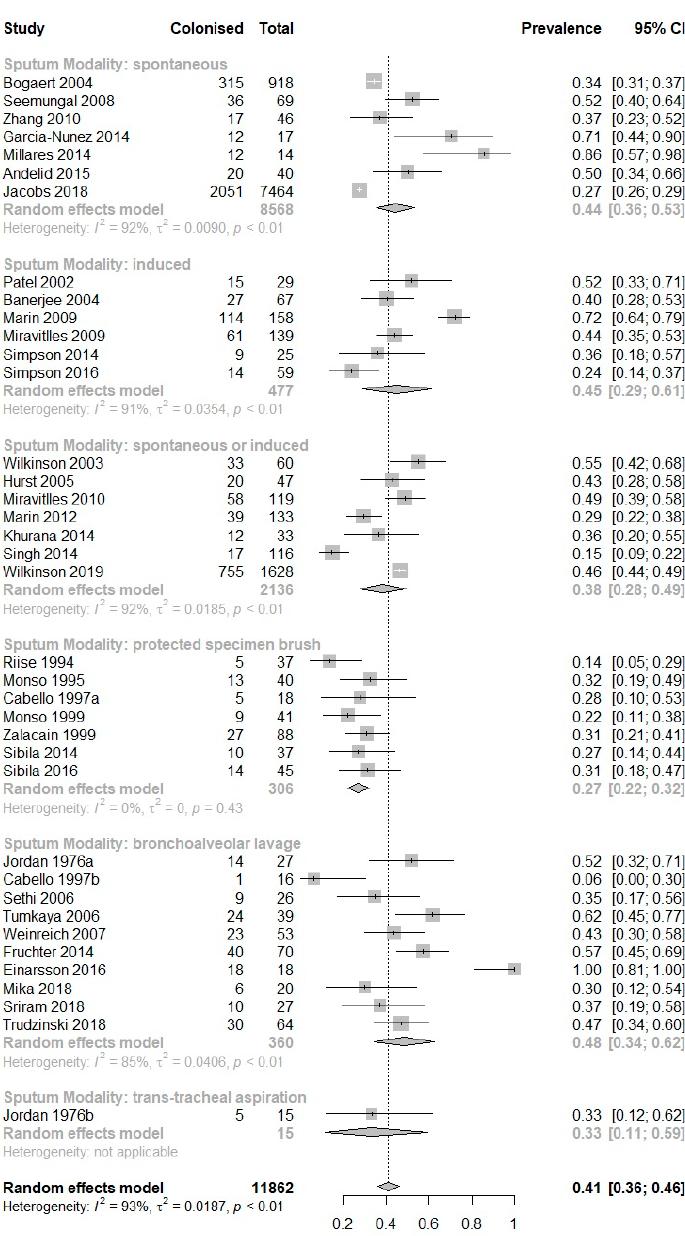
Figure 3. Meta ‐ analysis of prevalence of potentially pathogenic microorganisms in quantitative cul ‐ ture ‐ sub ‐ grouped by quantitative culture modality. culture-sub-grouped by quantitative culture